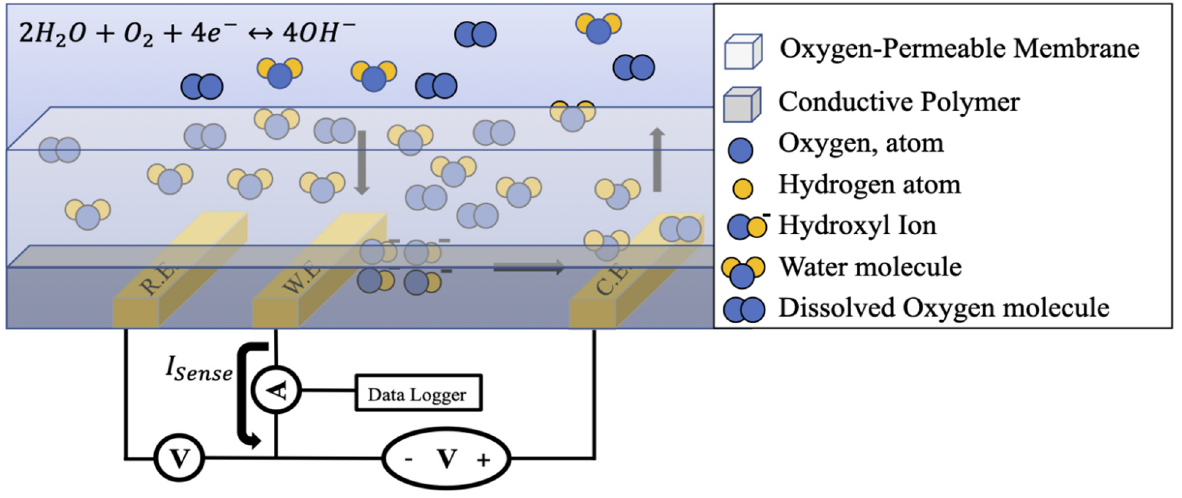
Figure 1. The working principle of a solid-state sensor geometry for dissolved oxygen electrochemical sensing. The reference and working electrodes are biased below the counter electrode in order to reduce oxygen and induce electronic charge transfer through the working electrode. The oxygen concentration is then captured by measuring the electron transfer rate as current.